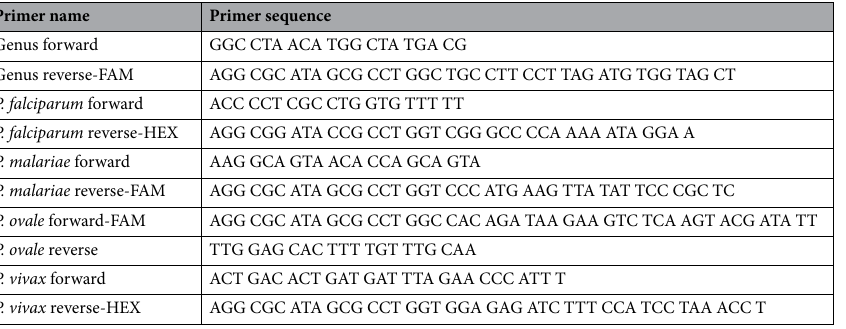
Table 3. PET-PCR primers utilized in this